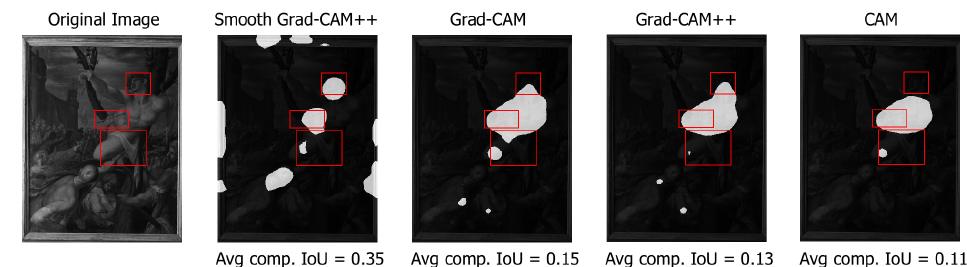
Figure 7. Different values of component IoU produced by different class activation map algorithms (Smooth Grad-CAM++ with σ = 1 and s = 5) at threshold t = 0.1. Ground-truth bounding boxes are shown in